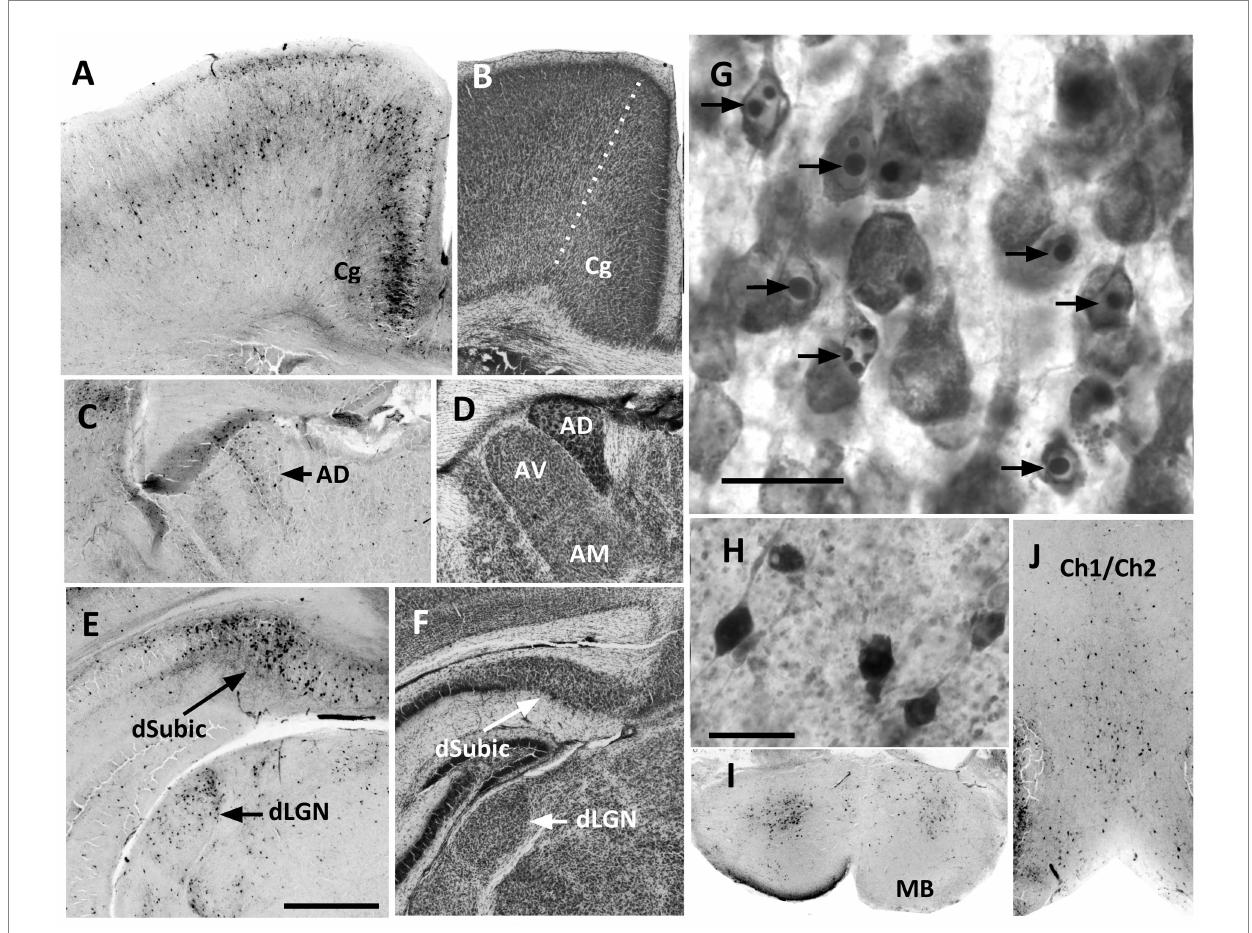
FIGURE 1 In P7 brains, identification of apoptotic neurons by either CC3-immunolabeling or Nissl staining confirmed an obvious apoptotic response at 8 h after the initiation of treatment. (A) CC3-immunolabeling showed a high density of apoptotic cells in the cingulate cortex (Cg), that was present in all cortical layers but were especially dense in layer II and III/IV. (B) A Nissl-stained section shows the border (dotted line) of cingulate cortex with motor cortex laterally. Cingulate cortex was distinguished by the dense cell packing in layer II. (C) CC3 cell density was consistently high in the anterior dorsal nucleus of the thalamus (AD). (D) In Nissl-stained sections the AD nucleus has a characteristic dense appearance. The anterior ventral (AV) and anterior medial (AM) nuclei are also easily identified, although at P7 the border separating the two was somewhat indistinct. (E) The dorsal subiculum (dSubic) and dorsal lateral geniculate nucleus (dLGN) had a high density of CC3 cells after P7 ethanol. (F) In Nissl-stained sections the dSubic and dLGN were easily identified. (G) Higher magnification image of Nissl-stained cortex shows the typical appearance of apoptotic cells, which were easily identified by characteristic darkly stained ovals of condensed chromatin within the nucleus. (H) Higher magnification shows the appearance of CC3-immunolabeled cells, most of which had the appearance of neurons. (I,J) CC3-immunolabeling was prominent in the cell scattered throughout the mammillary bodies (MB) and the region of the medial septal nucleus/vertical diagonal band (Ch1/Ch2). Scale bar in E = 0.5 mm, and applies to all images except (G,H) . Scale bars in (G,H) = 20 μ